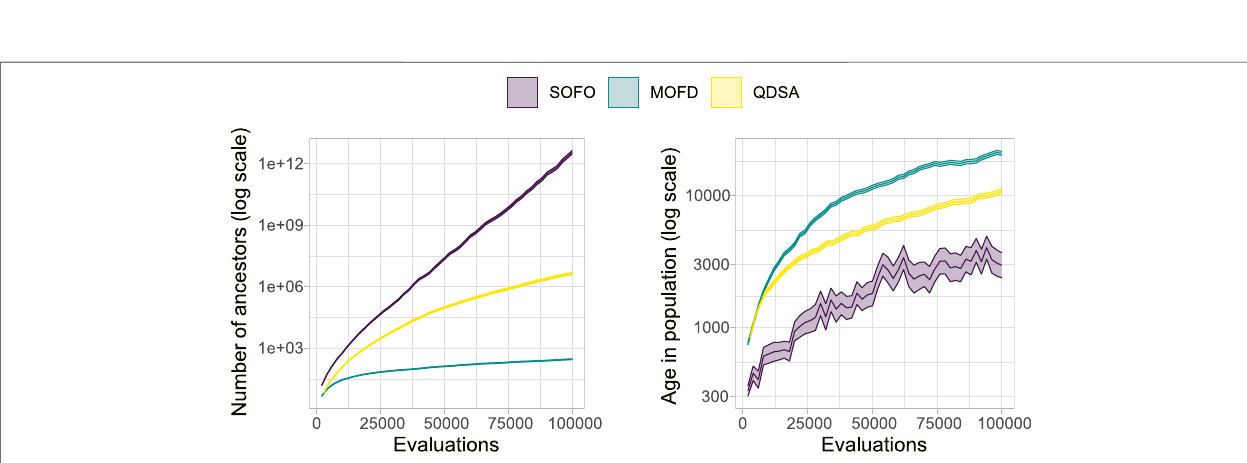
Frontiers in Robotics and AI |